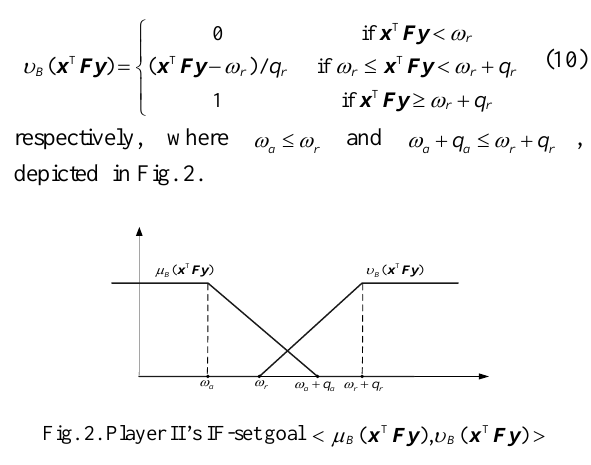
Fig. 2. Player II’s IF-set